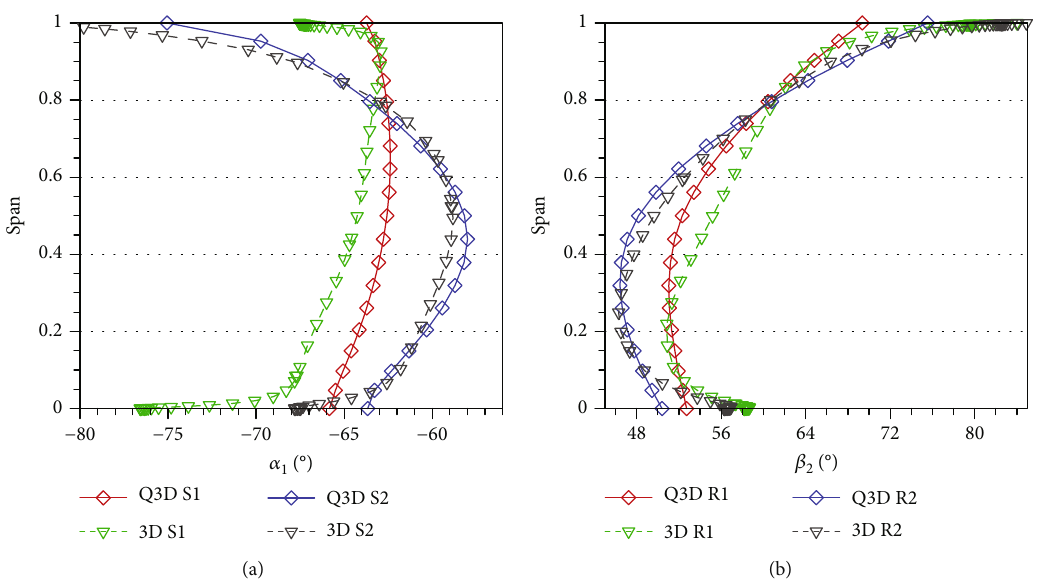
Figure 12: Swirl of the two-stage turbine: (a) stator; (b) rotor.